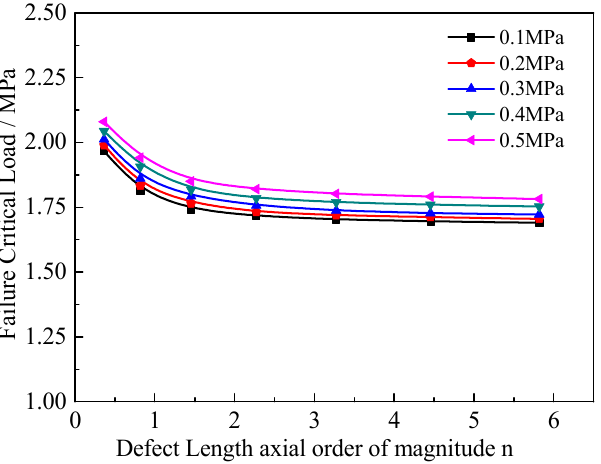
Figure 19. Critical failure load of HDPE pipe with different defect lengths.